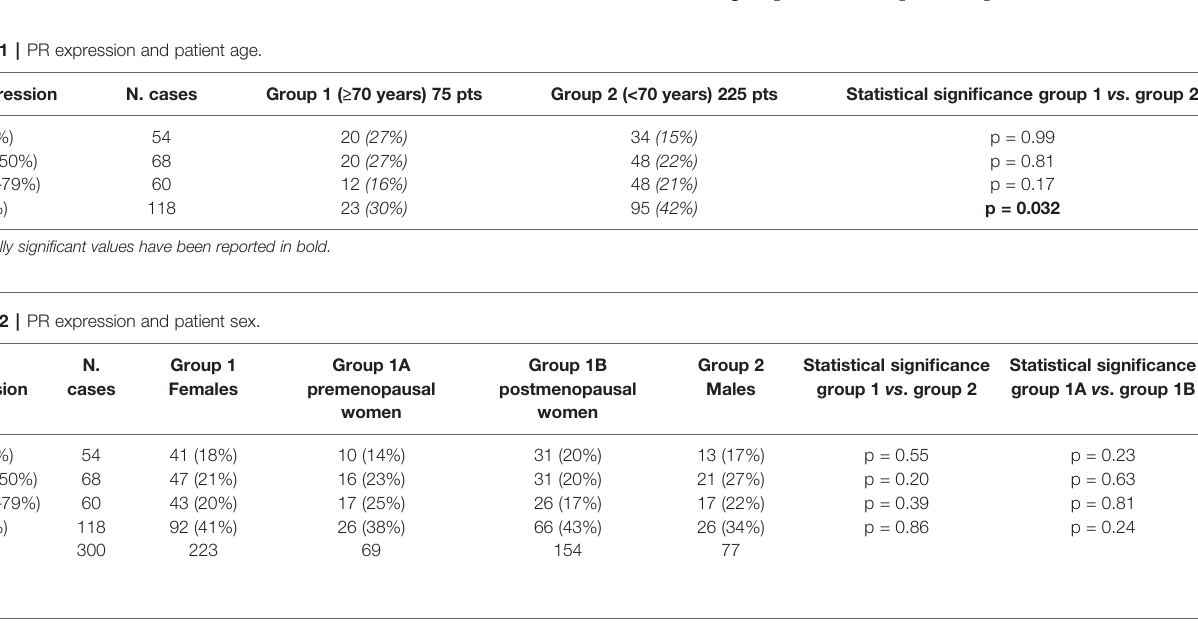
FIGURE 1 | Immunohistochemical evaluation of progesterone receptor antibody expression: nuclear signal respectively in less than 1% (A) , in 15% (B) and in 95% (C) of neoplastic cells (×200 magni fi cation).